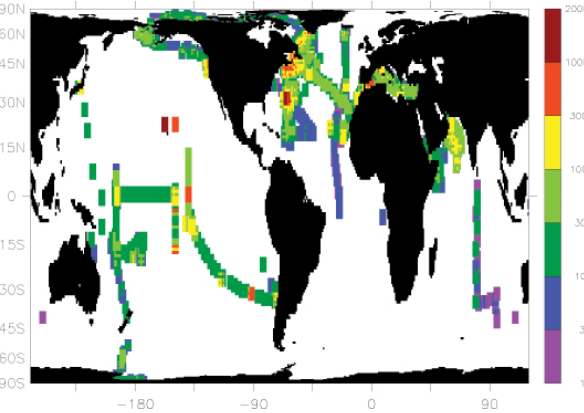
Figure 1. Horizontal distribution of the number of observations. Data points have been enlarged to 5 ◦ × 5 ◦